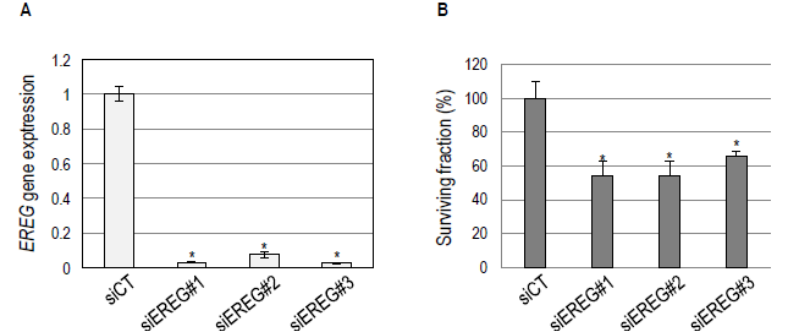
Figure 4. EREG expression inhibition decreases BHY basal cell clonogenic survival. ( A ) RT-qPCR analysis of the expression of the EREG gene in BHY cells transfected with three independent anti- EREG siRNAs (si EREG #1, 2, and 3). Cells transfected with scrambled siRNA were used as a negative control (siCT). Transfection with si EREG siRNAs yielded a significant > 90% inhibition of EREG expression. ( B ) Analysis of the clonogenic survival of BHY basal cells upon EREG expression inhibition. Transfection with si EREG #1, 2, and 3 significantly reduces BHY cell clonogenic survival. Cells transfected with scrambled siRNA were used as a negative control (siCT). Mean survival fractions and standard errors from three independent experiments are shown. *: p <